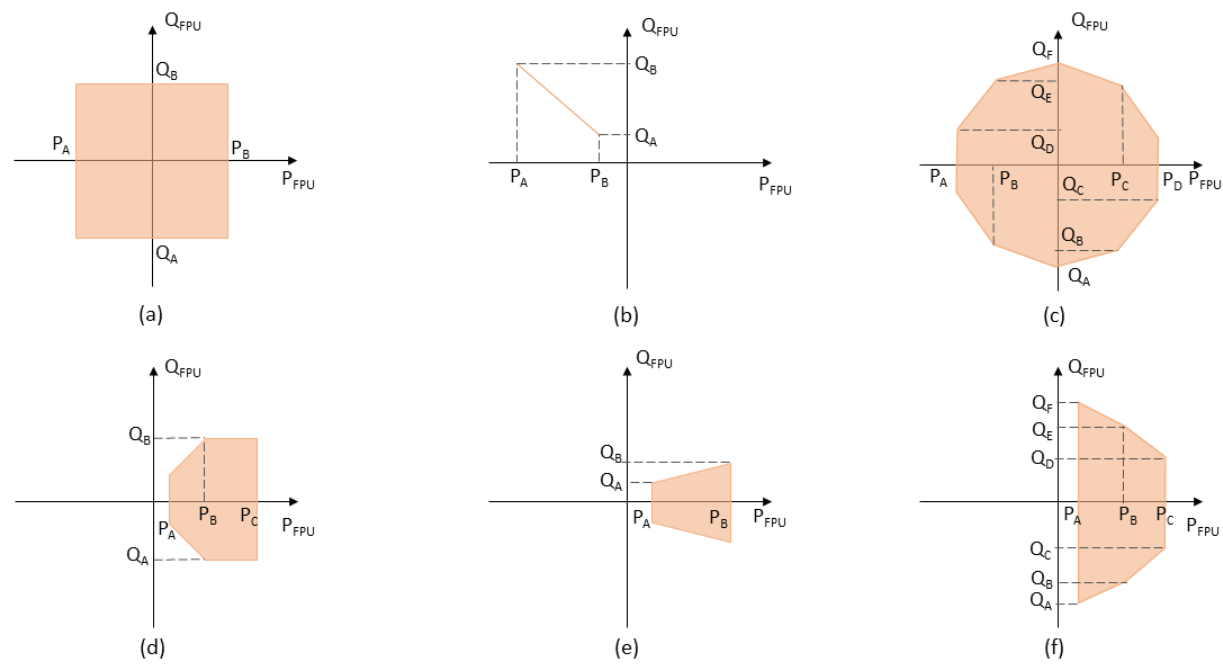
Figure 2. Capability charts of different types of FPUs: ( a ) generic FPU, ( b ) controllable load, ( c ) battery storage system, ( d ) wind generator, ( e ) photovoltaic generator, and ( f ) synchronous generator.